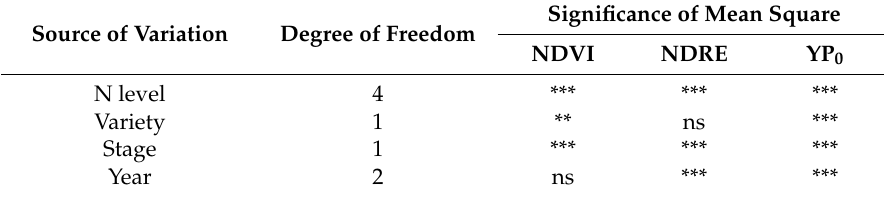
Table 3. Significance of mean squares in the analysis of yield without additional topdressing N application (YP 0 ), RapidSCAN NDVI, and NDRE under five N rates (0, 40, 80, 120, 180 kg ha − 1 ) combined at two stages (stem elongation and heading stage), across three years (2014-2016) for two varieties (Longjing 31 and Longjing 21).